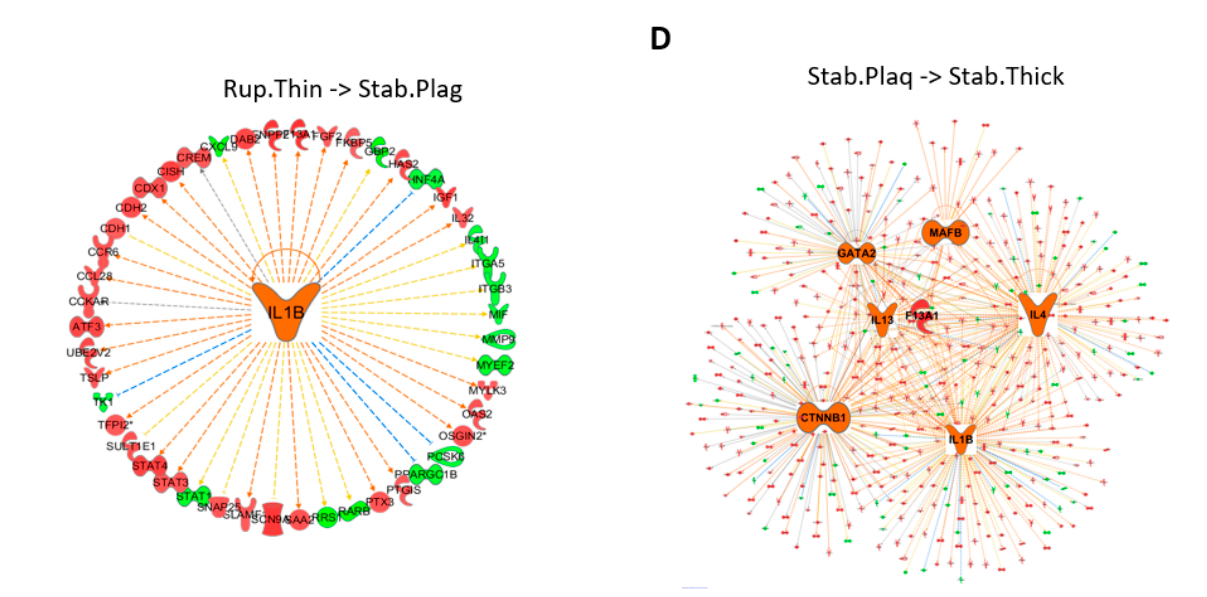
Figure 6. The expression analysis of plaque stability. ( A ) F13A1 expression in plaque stability. ( B ) 3D-PCA of plaque-stability-derived data points. Blue: Ruptured Thin Fibrous Cap Atheroma; yellow: Stable Thick Fibrous Cap Atheroma; and dark pink: Stable Fibrocalcific Plaque. ( C ) 3D-PCA of significant F13A1-expression-correlated genes at p < 0.05; left: significantly correlated genes with F13A1 expression in Ruptured Thin Fibrous Cap Atheroma to Stable Fibrocalcific Plaque; and right: significantly correlated genes with F13A1 expression in Stable Fibrocalcific Plaque to Stable Thick Fibrous Cap Atheroma. ( D ) Significant upstream regulators of F13A1-expression-correlated genes in left: Ruptured Thin Fibrous Cap Atheroma to Stable Fibrocalcific Plaque; right: Stable Fibrocalcific Plaque to Stable Thick Fibrous Cap Atheroma; orange: predicted overexpressed; blue: predicted under-expressed; red: overexpressed; and green: under-expressed in Ruptured Thin Fibrous Cap Atheroma compared to Stable Fibrocalcific Plaque or Stable Fibrocalcific Plaque compared to Stable Thick Fibrous Cap Atheroma .